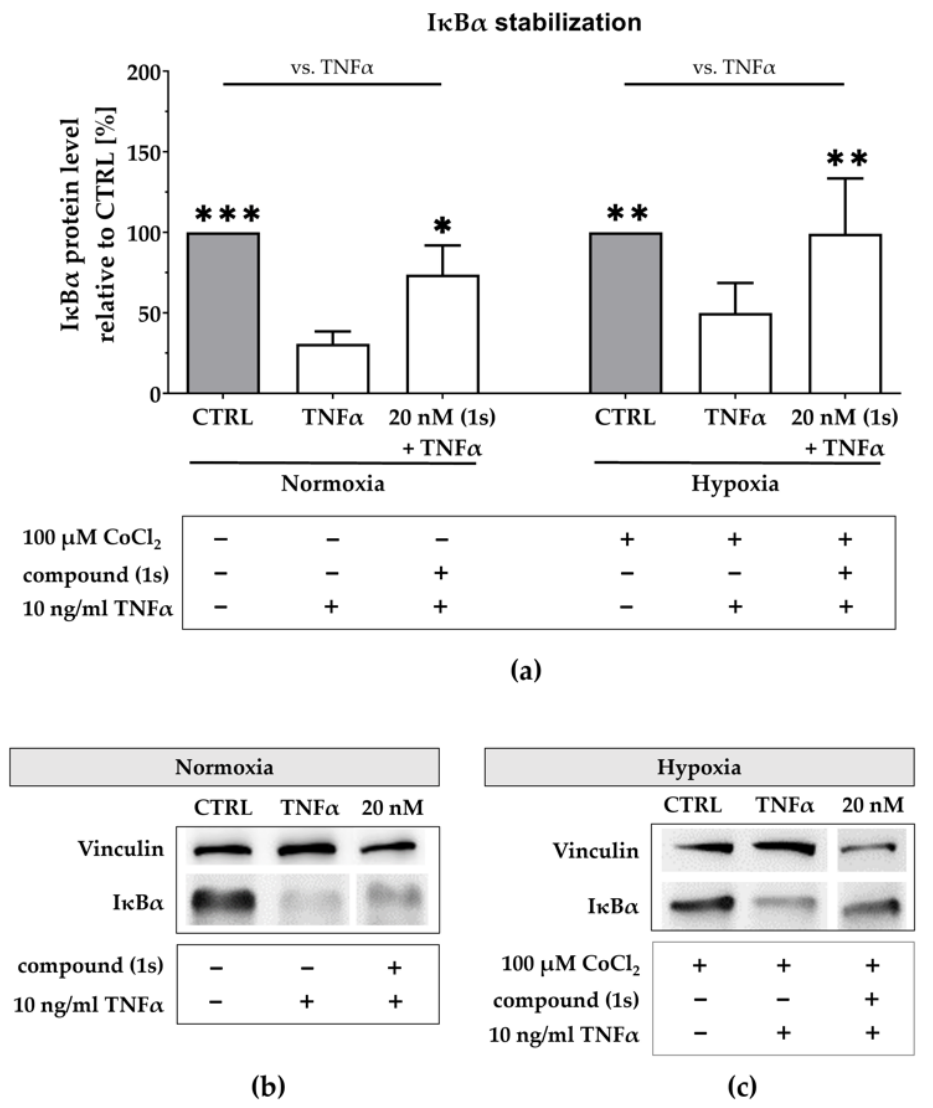
Figure 8. Compound ( 1s ) stabilizes I κ B α under normoxic and under hypoxic conditions. ( a , c ) For hypoxia studies, MDA-MB-468-UnaG cells were exposed to 100 µ M CoCl 2 for 24 h prior to treatment. ( a – c ) Cells were left untreated (CTRL), stimulated with solely 10 ng/mL TNF α for 30 min (TNF α ), or pre-incubated with 20 nM of compound ( 1s ) for 1 h before stimulation with TNF α for 30 min. ( a ) Normalized I κ B α protein level is displayed relative to CTRL. Statistical difference vs. TNF α was calculated with two-way ANOVA (* p < 0.05, ** p < 0.01, *** p < 0.001). Columns represent the mean ± SD of (normoxia n = 3; hypoxia n = 2). ( b , c ) Representative western blot with protein lysates that are immunologically stained for I κ B α and the housekeeper protein